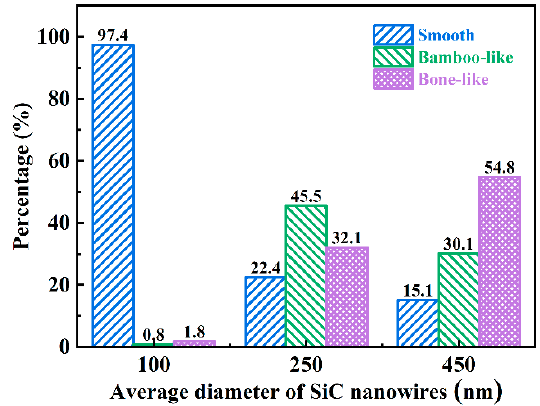
Figure 4. Statistical results of SiCnws’ morphology.